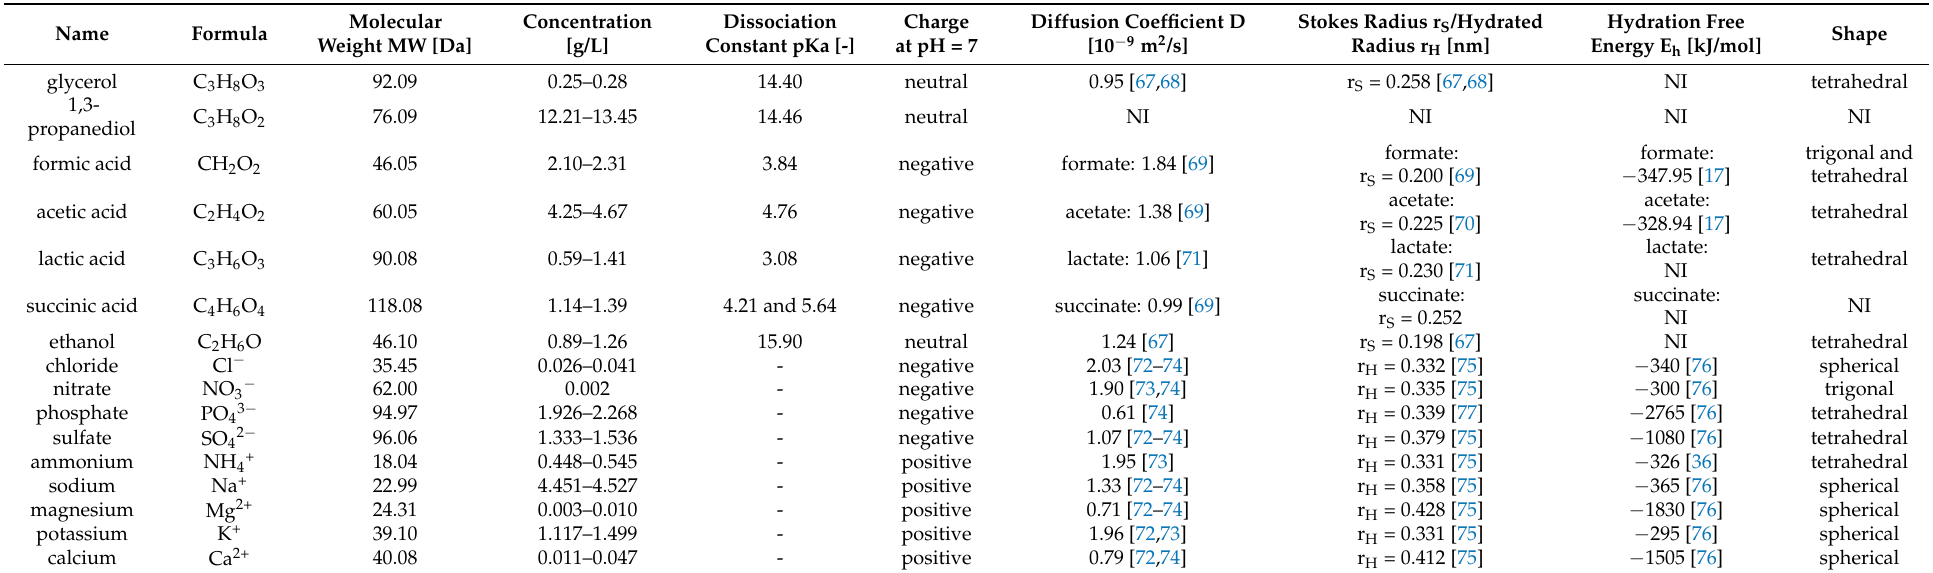
Table 1. Chemical species in fermentation broths and their associated